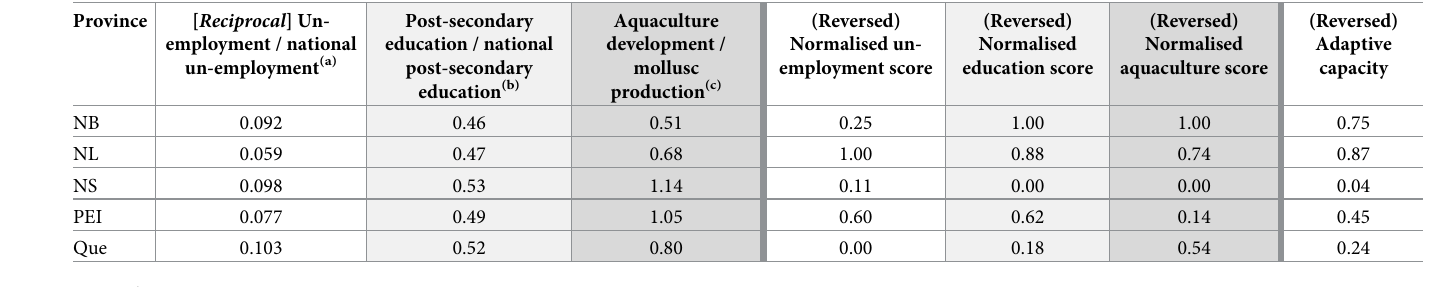
Table 4. Indicators scores for adaptive capacity. Columns 2–4 present absolute scores for each indicator. Normalised indicators were reversed (i.e., subtracted from 1.0) (columns 5–7), so that low indicator scores contributed to higher potential. The combined adaptive capacity score (last column) is the average of the reversed, normalised indicators. Adaptive capacity scores were combined with the sensitivity scores (as indicated in Fig 4) in Table 3 to define vulnerability for each province (Table